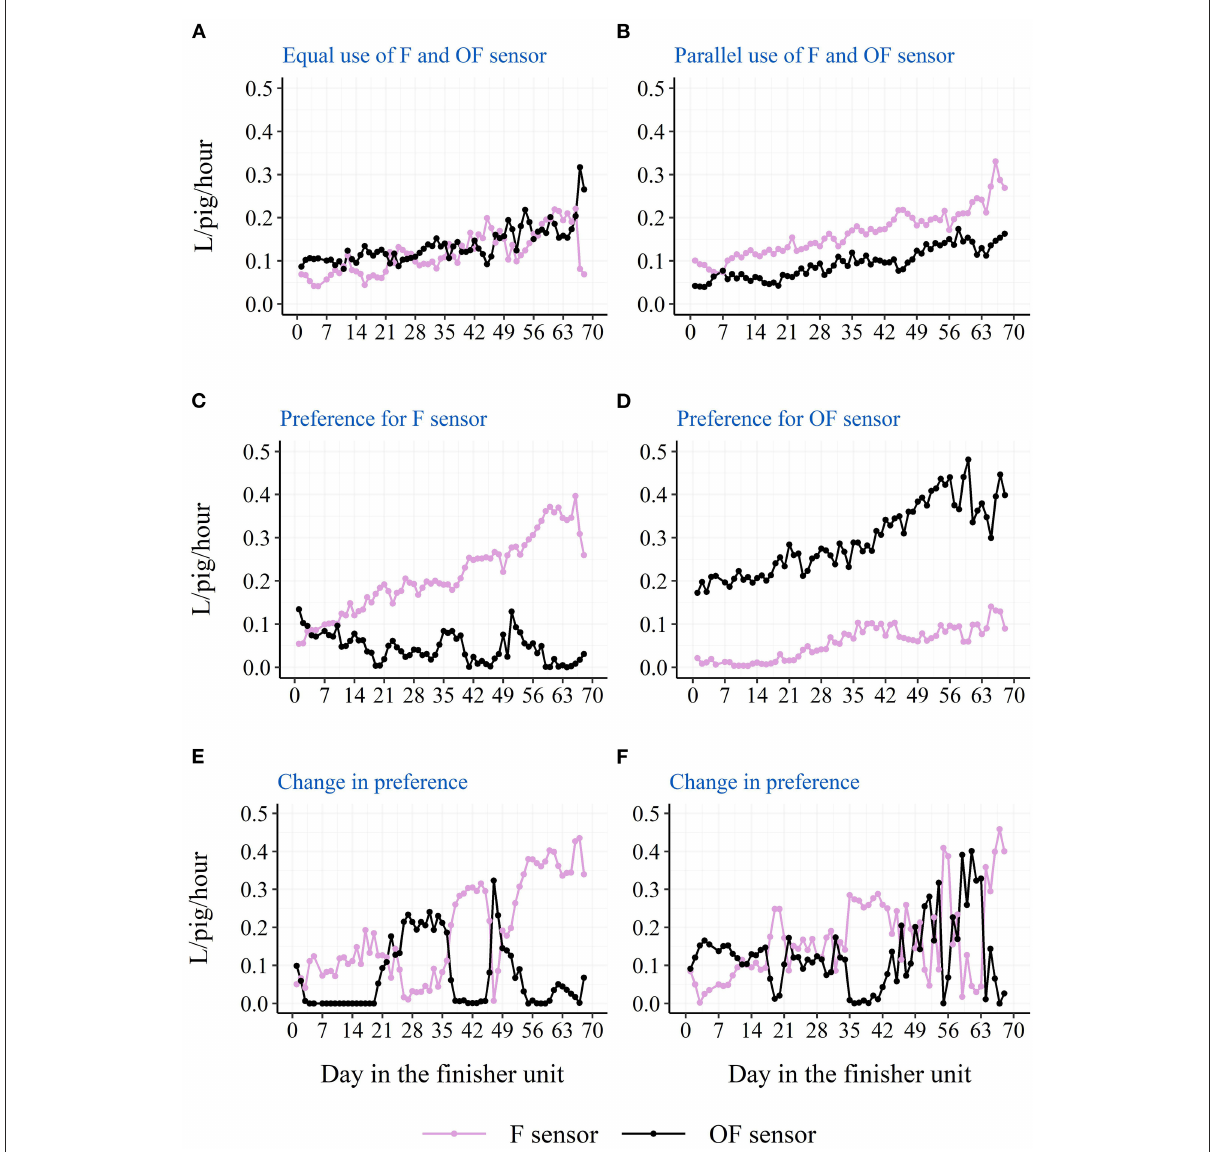
FIGURE7 Examples from batch 4 of single pens variations in raw average hourly water use from the two drinking cups (F sensor: at the same side of the pen as the feeder; OF sensor: on the opposite side of the pen as the feeder). (A) Docked tails, without straw, high stocking density. (B) Docked tails, with straw, low stocking density. (C,D) Docked tails, without straw, low stocking density. (E,F) Docked tails, with straw, high stocking